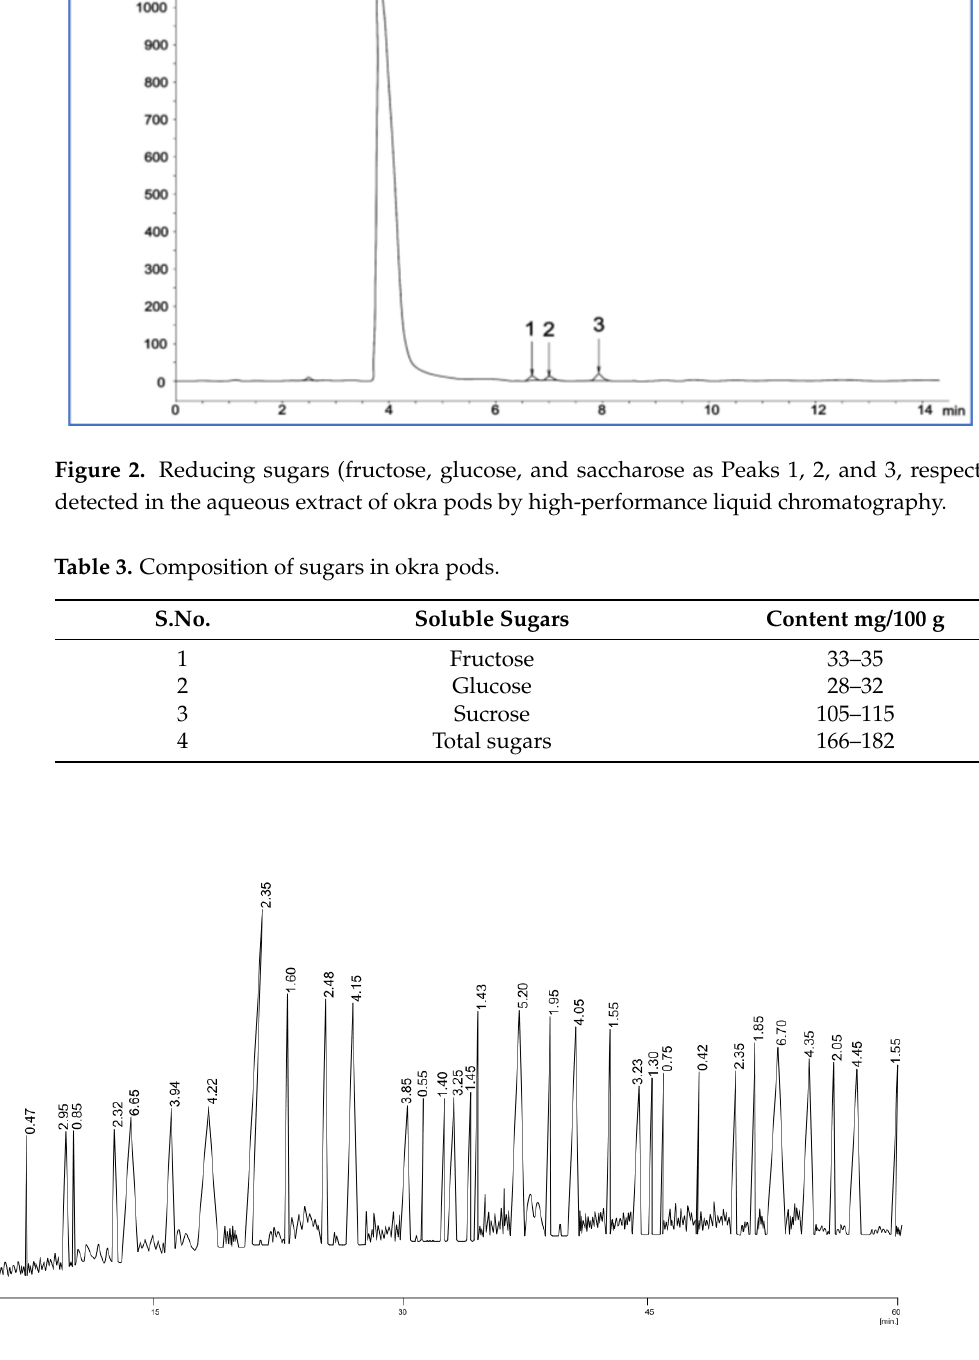
Figure 3. GC – MS chromatogram representing the bioactive constituents of aqueous extract of okra Figure 3. GC–MS chromatogram representing the bioactive constituents of aqueous extract of pods. okra